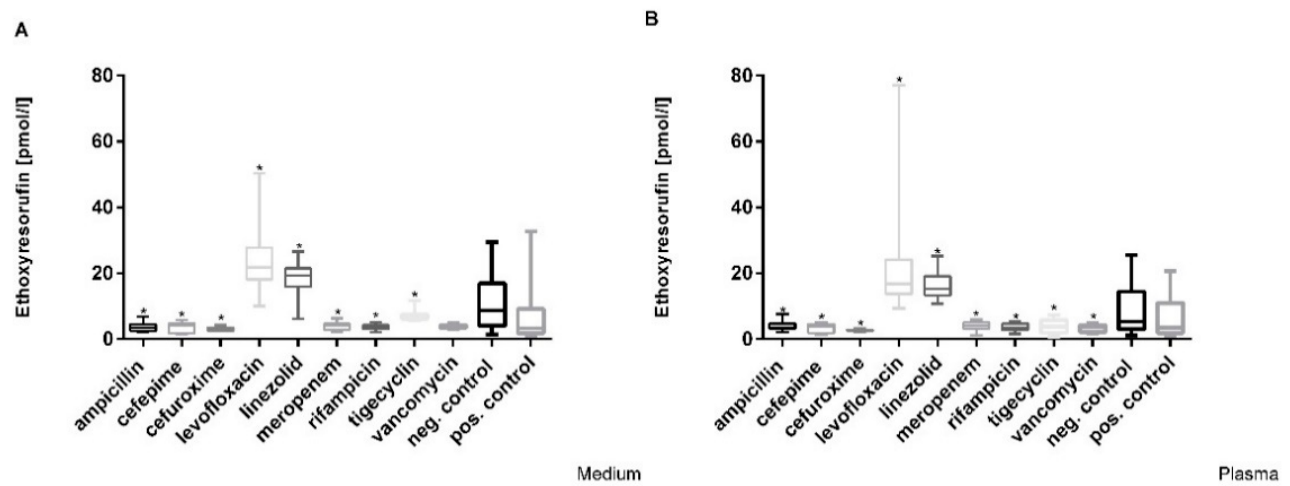
Figure 5. EROD induction in hepatocytes incubated at Cmax and exposed to ( A ) antibiotics in medium and ( B ) antibiotics in plasma. Values represent median and 25th/75th percentile of three replicate wells from four experiments. Significant difference between the control and exposure groups is indicated by * p < 0.05.